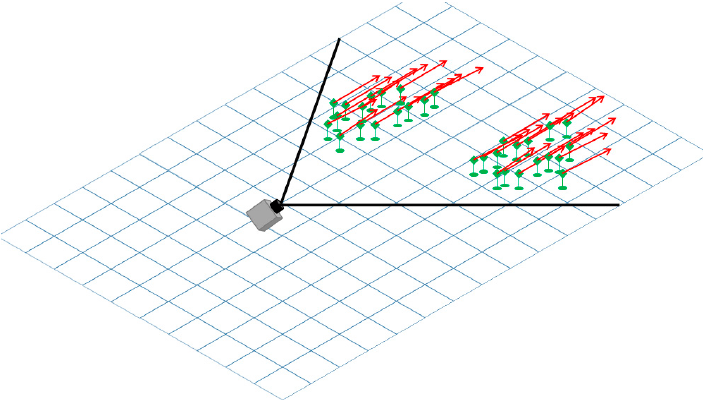
Figure 2. Particle-based probabilistic world model. The occupied cells in front of the camera are parts of two vehicles moving in the same direction as our own vehicle.